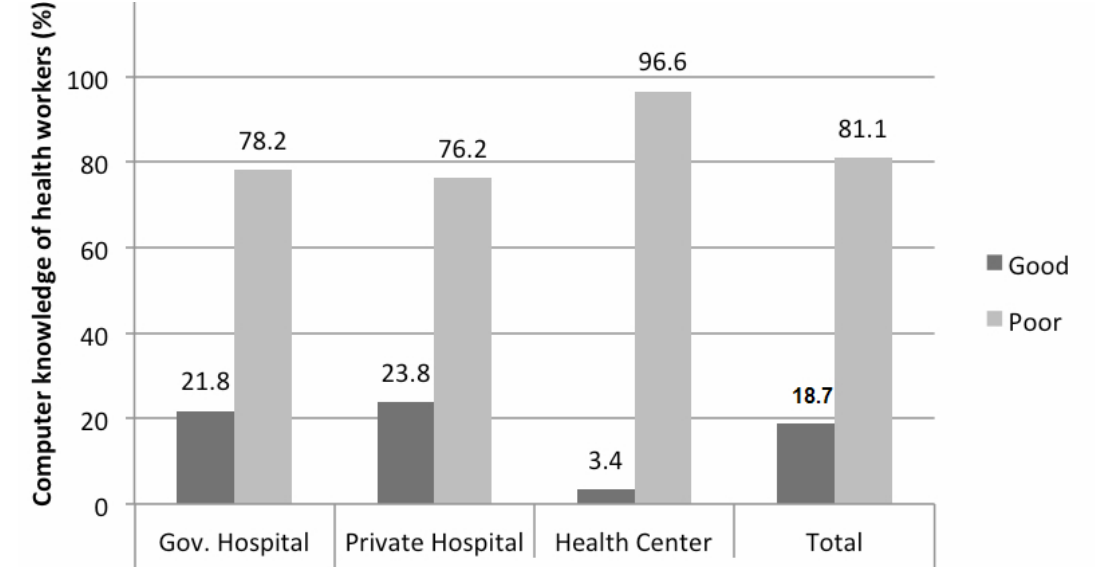
Figure 1. Knowledge of computers among health professionals.